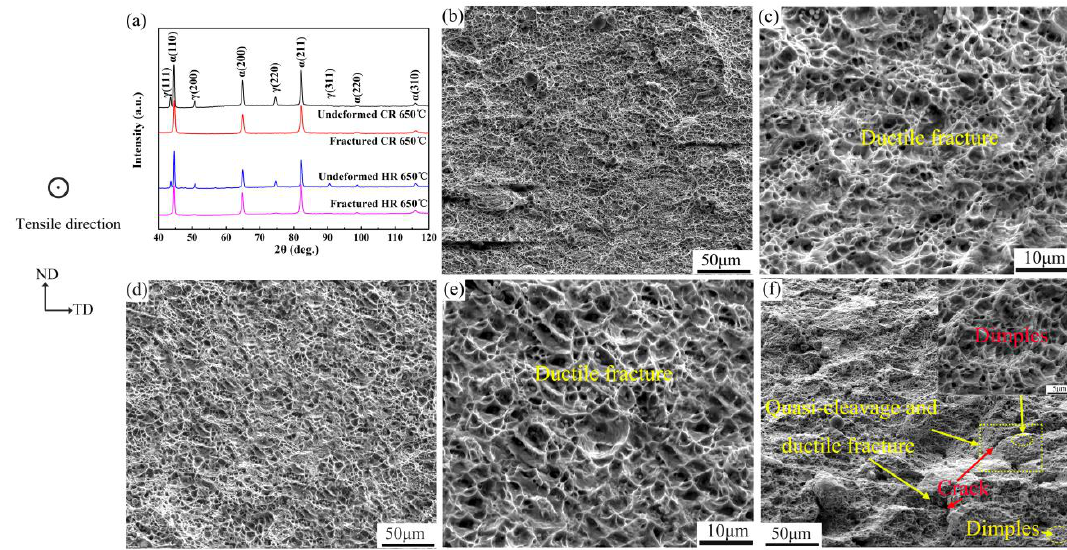
Figure 7. Transmission electron microscope (TEM) micrographs of ( a )–( c ) HR 650 °C sample, ( d )–( f ) CR 650 °C sample. ( a ) granular austenite grains, ( b ) staking faults and filmy austenite grains, ( c ) blocked austenite grains, ( d ) Mn concentration of the selected austenite grains of the CR 650 °C sample determined by TEM-energy dispersive X-ray spectroscopy (EDS), ( e ) filmy austenite grains, and ( f ) Mn content in austenite grains (RA: retained austenite). Table 2. The nominal, equilibrium and measured Mn content in austenite (wt.%)